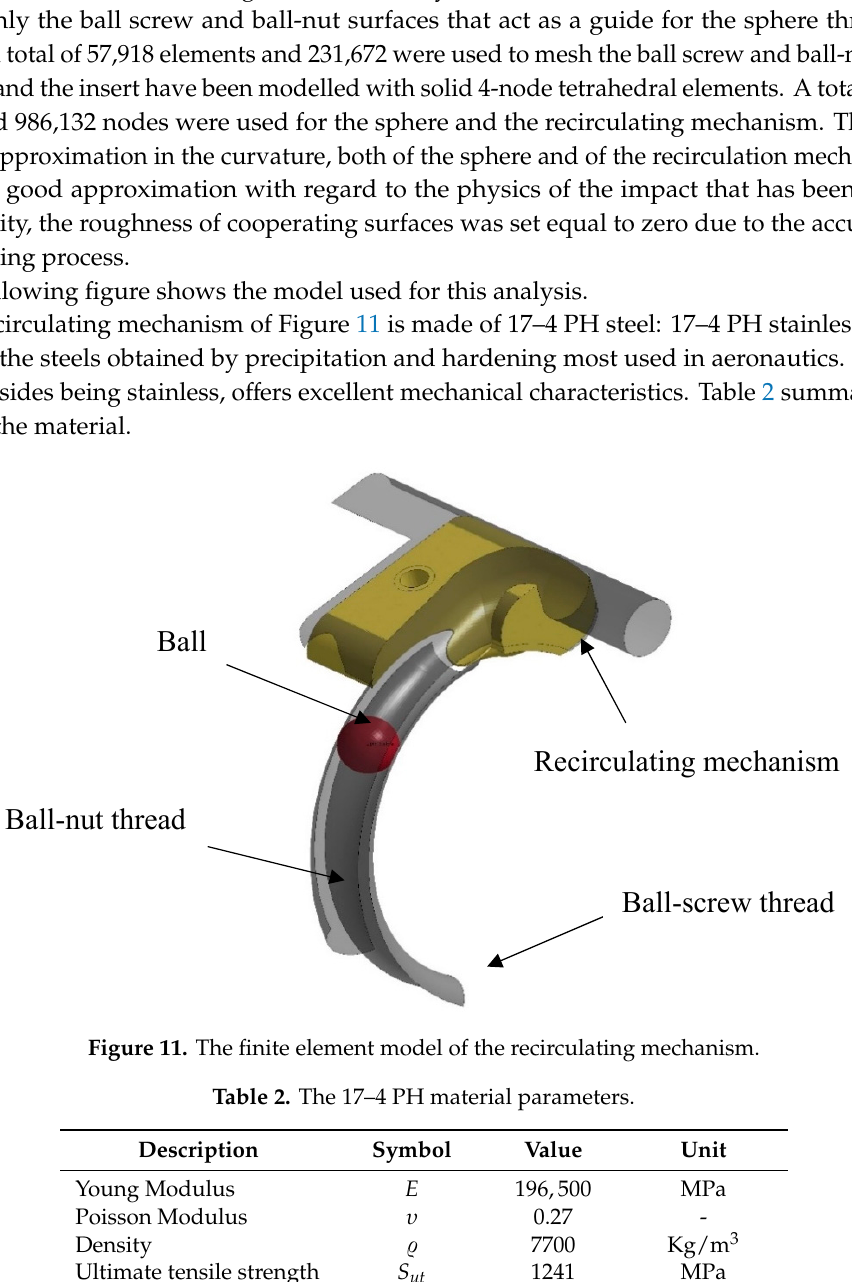
Table 2. The 17–4 PH material parameters.